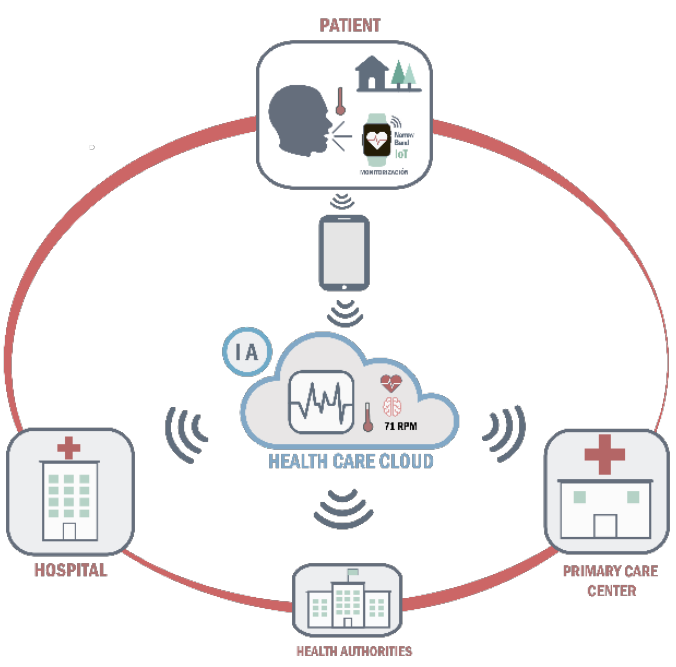
Figure 3. Clinical decision support system overview diagram.